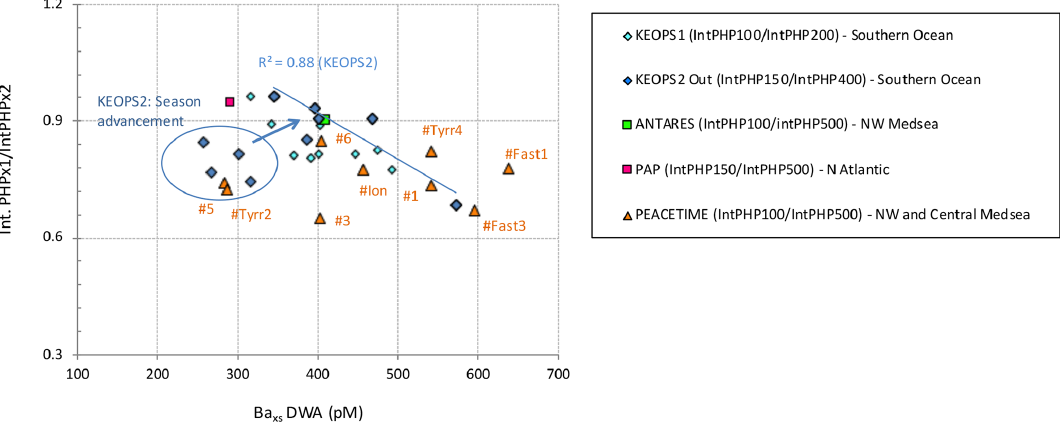
Figure 4. Ratio of surface layer integrated PHP (Int.PHPx1) to mesopelagic integrated PHP (IntPHPx2) vs. mesopelagic depth-weighted average (DWA) Ba xs (pM) during PEACETIME. The same data are reported for the KEOPS1 and KEOPS2 cruises (Southern Ocean; Jacquet et al., 2015) and at the PAP (northeastern Atlantic – “N Atlantic”) and ANTARES/EMSO-LO (northwestern Mediterranean Sea – “NW Medsea”) observatory sites (Jacquet et al., 2021). The blue line ( R 2 = 0 . 88) represents the trend reported during KEOPS2 (Jacquet et al., 2005). The data points referred to as “season advancement” (encircled by the blue line) were excluded from the KEOPS2 regression analysis shown here.